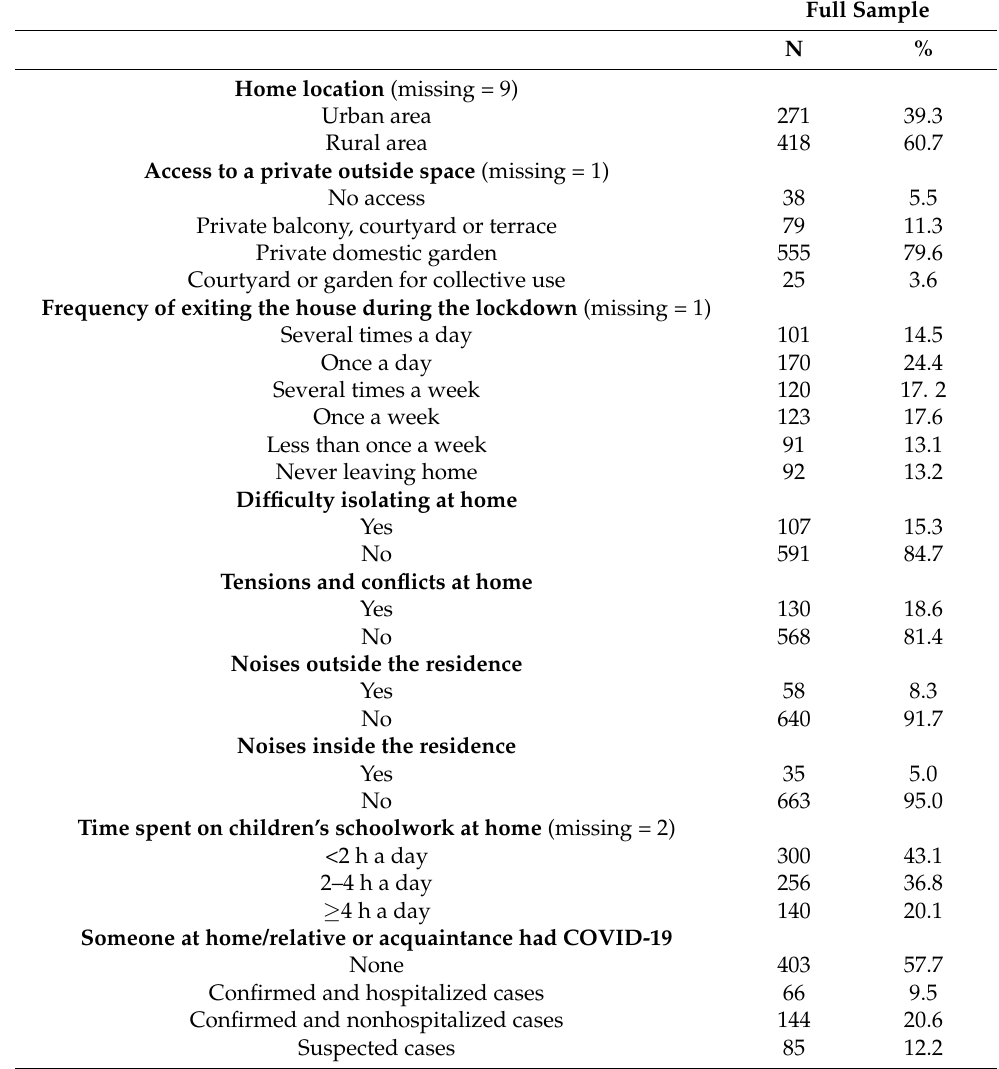
Table 2. Living conditions of the sample population of parents during the lockdown (N =